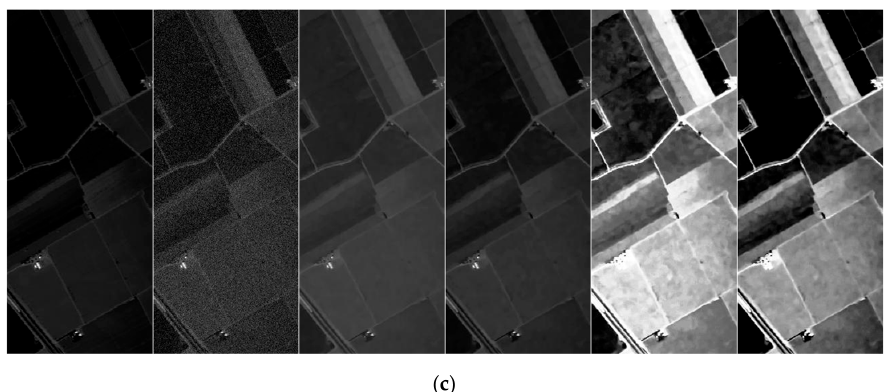
Figure 8. Visualization comparison results of three public datasets using different methods. ( a ) Ex- perimental results of band 50 in the Indian Pines dataset. ( b ) Experimental results of band 1 in the PaviaU dataset. ( c ) Experimental results of Band 11 in the Salinas dataset. Each line from left to right represents ground truth, degraded data, BM4D, BM4D + LS, BM4D + HE, and the proposed method.